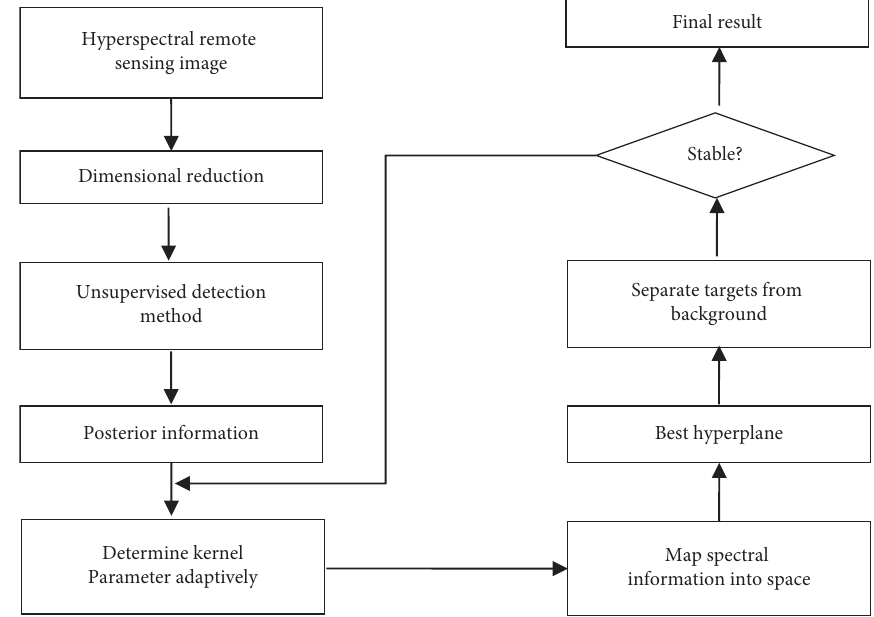
Figure 1: Flowchart of the small target detection method in hyperspectral remote-sensing